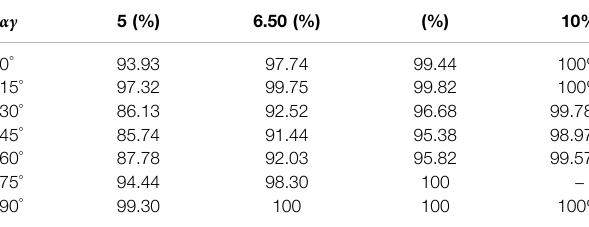
TABLE 4 | Strength exertion S of the remold loess ( b = 0).